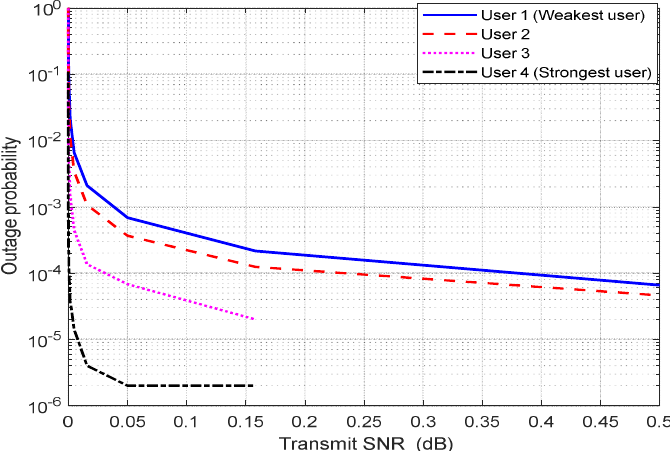
Figure 18. OP against SNR for four users with varying distances, with 64 × 64 MIMO and BW 200 MHz for UL NOMA.